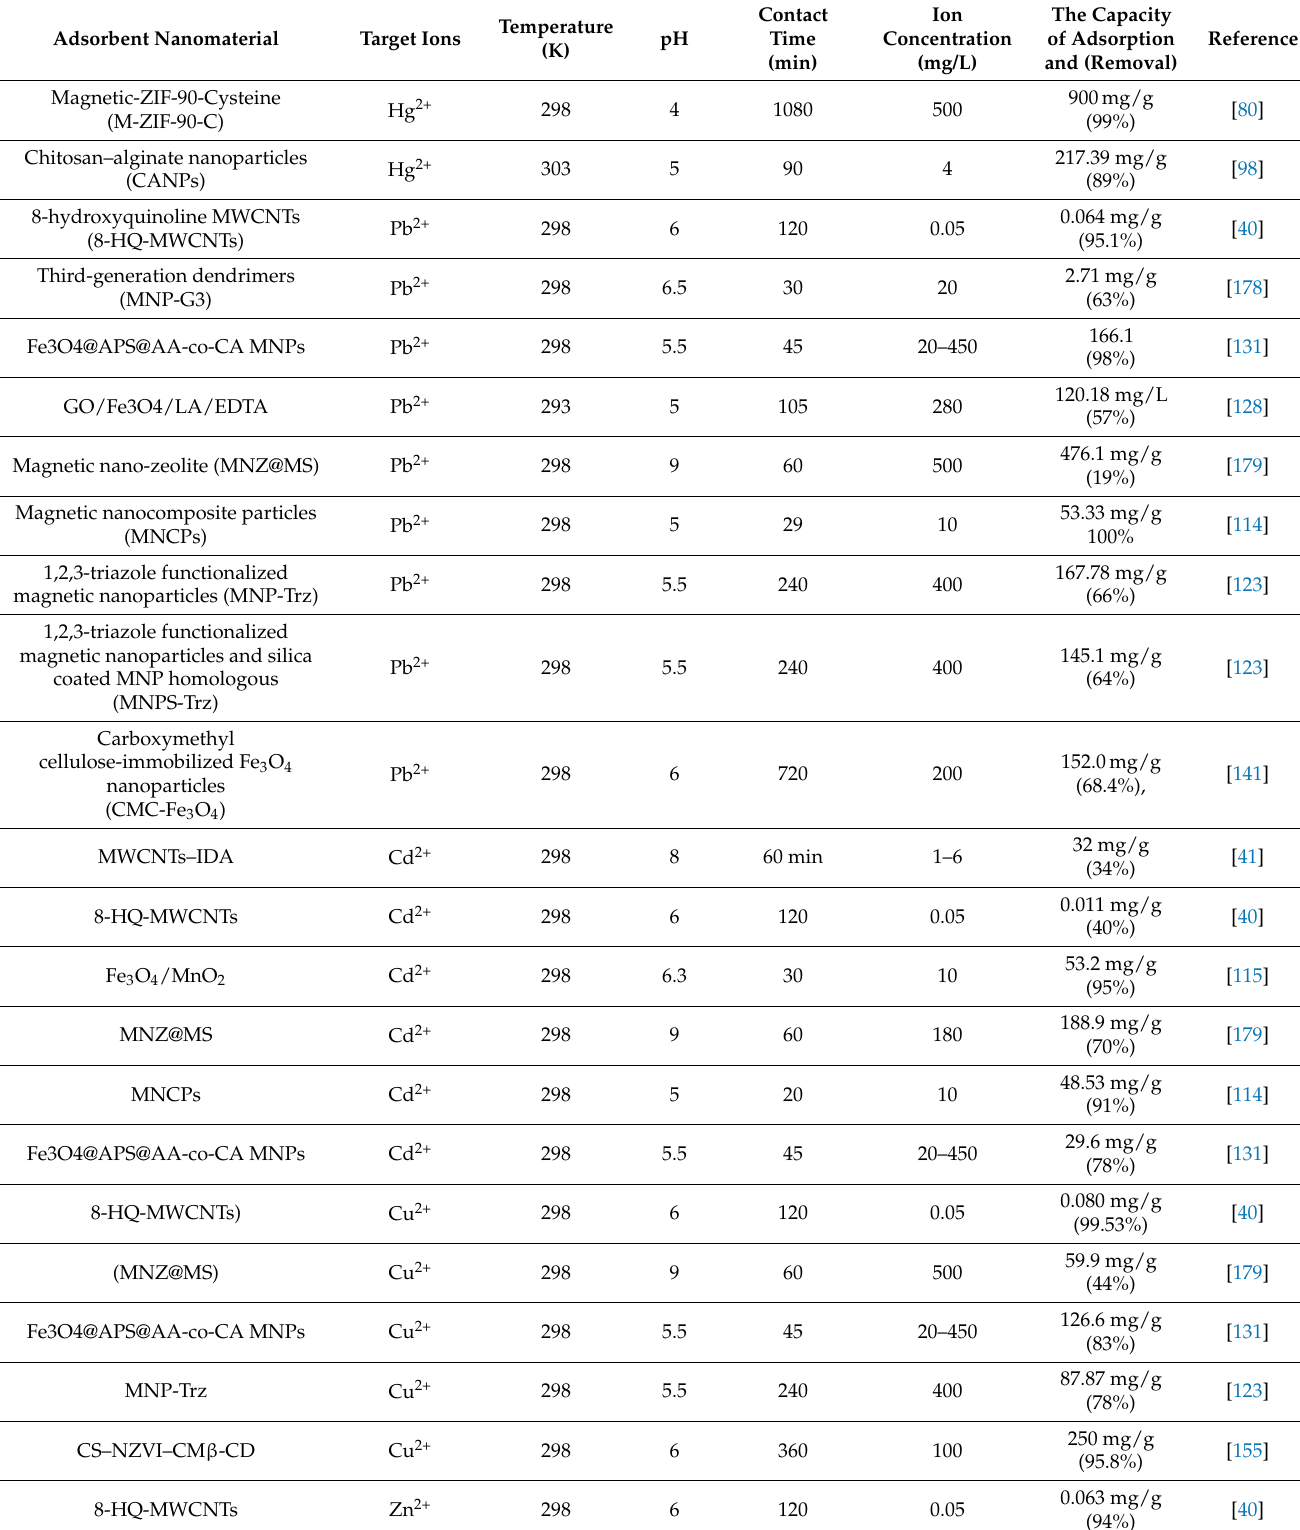
Table 3. The capacity of adsorption and removal efficiency for various heavy metals using different